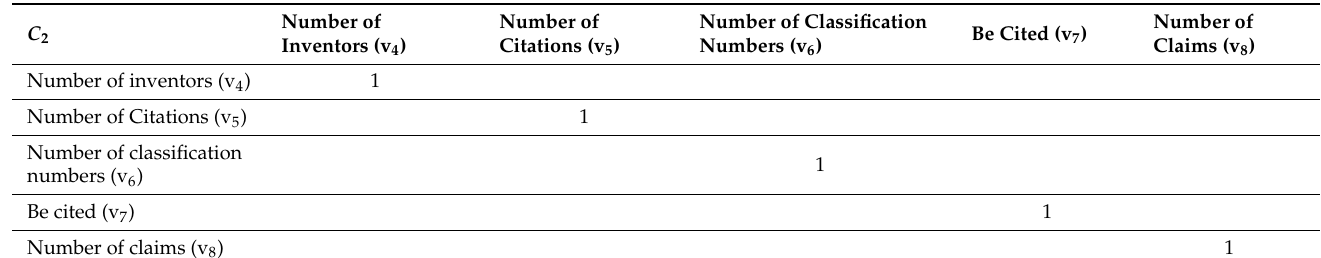
Table A3. Judgment of the importance of technical value indicators.